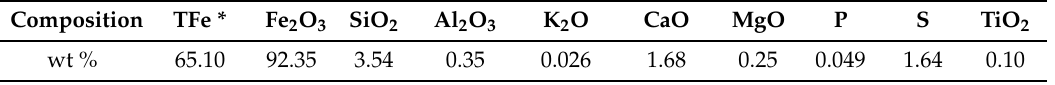
Table 1. Chemical analysis results of magnetic concentrate (mass fraction, %).